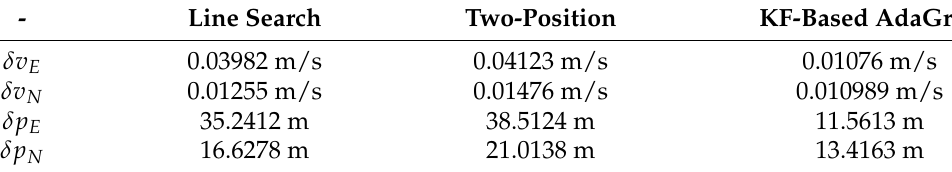
Table 7. RMS of velocity and position errors.